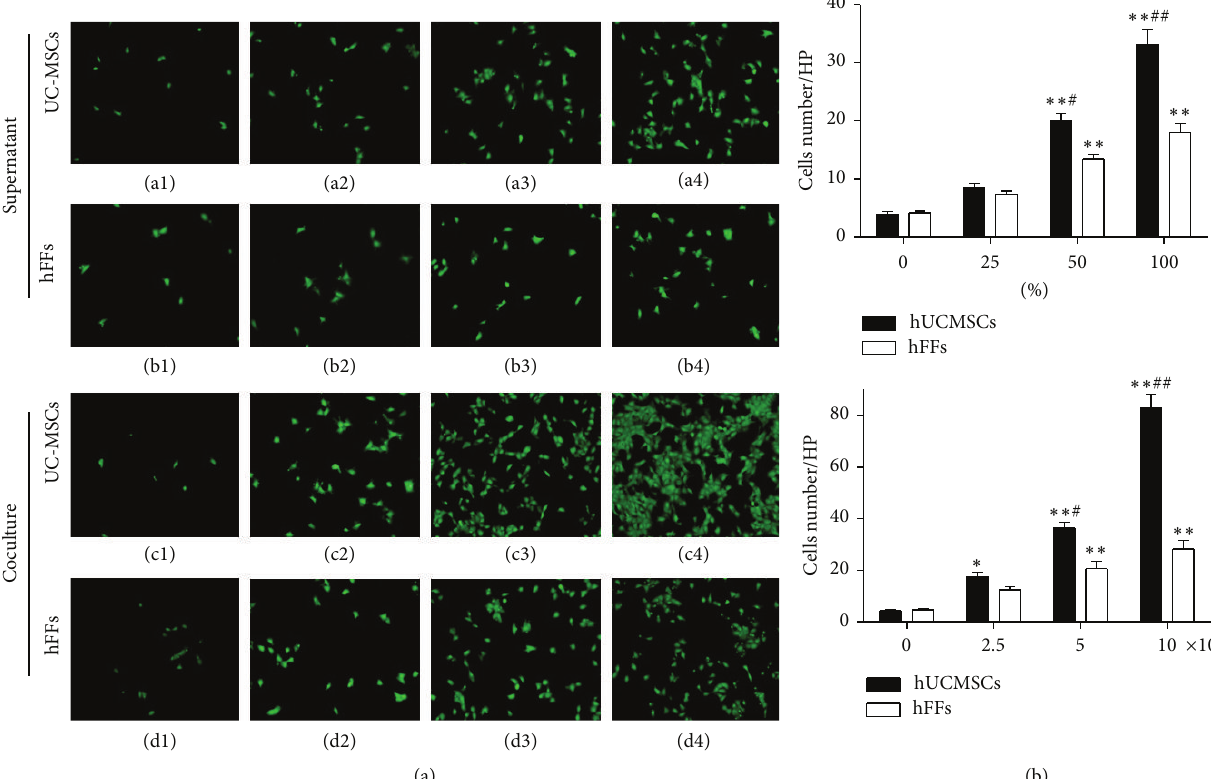
Figure 6: Effect of hUCMSCs and hFFs on the invasion ability of HTR-8/SVneo cells. (a) HTR-8/SVneo cells (4 × 10 4 cells/well) were cultured in medium containing 0, 25, 50, or 100% hUCMSC (a1–a4) or hFF (b1–b4) supernatant in Transwell inserts for 24 hours or were cocultured with hUCMSCs (c1–c4) or hFFs (d1–d4) at a concentration of 0, 2.5, 5, or 10 × 10 4 cells/well in Transwell inserts for 24 hours. Cells that had invaded were stained with calcein-AM. (b) HTR-8/SVneo cells that had invaded were counted after staining. ∗ represents significant differences versus control ( 𝑃 < 0.05 ); ∗∗ represents very significant differences versus control ( 𝑃 < 0.01 ); # represents significant differences between hUCMSCs and hFFs at an individual dose ( 𝑃 < 0.05 ); ## represents very significant differences between hUCMSCs and hFFs at an individual dose ( 𝑃 < 0.01